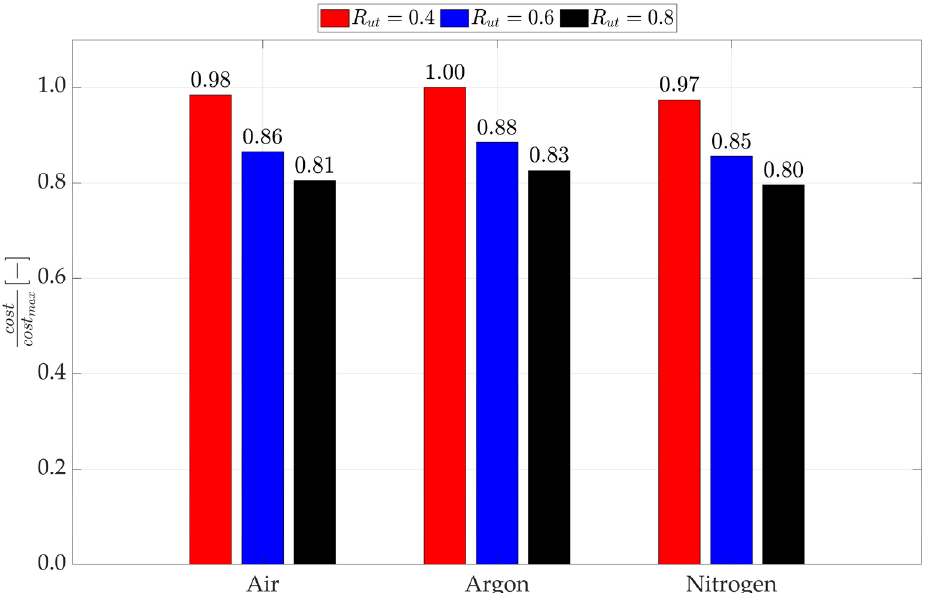
Figure 5. Impact of the operating fluid on the cost for the SBPTES. The results are related to air, argon and nitrogen; the cost was normalised with the maximum value to highlight the relative cost increments between the fluids. The results refer to a configuration with η rt ≈ 0.58.